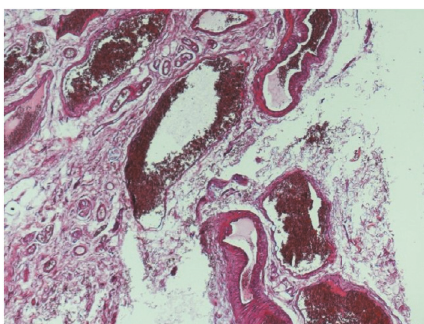
Figure 1: Photomicrograph shows hemorrhoids comprised of dilated, thick walled, congested submucosal blood vessels (hema- toxylin and eosin stain, original magnification × 40).